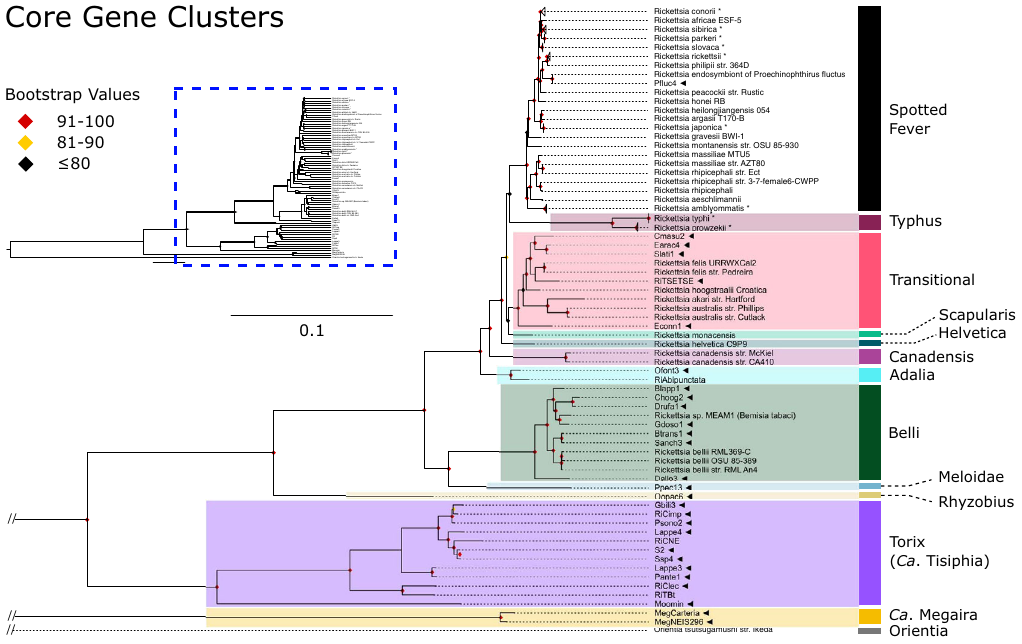
Fig. 1 Genome wide phylogeny of Rickettsia and ‘ Ca . Megaira ’ . Maximum likelihood (ML) phylogeny of Rickettsia and ‘ Ca . Megaira ’ constructed from 74 core gene clusters extracted from the pangenome. New genomes are indicated by ◄ and bootstrap values based on 1000 replicates are indicated with coloured diamonds (red = 91 – 100, yellow = 81 – 90, black < = 80). New complete genomes are: RiCimp, RiClec and MegNEIS296. Asterisks indicate collapsed monophyletic branches and “ // ” represent breaks in the branch. Accessions used are provided in Supplementary Data